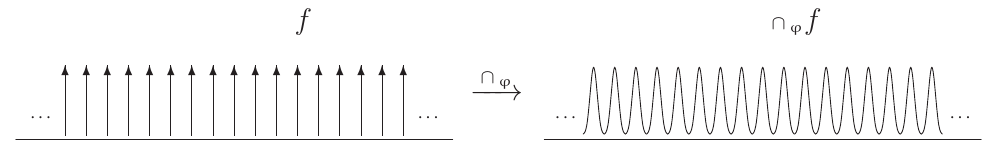
Figure 1. The regularization of generalized function f yields regular function Figure 1. A regularization of generalized function f yields regular function